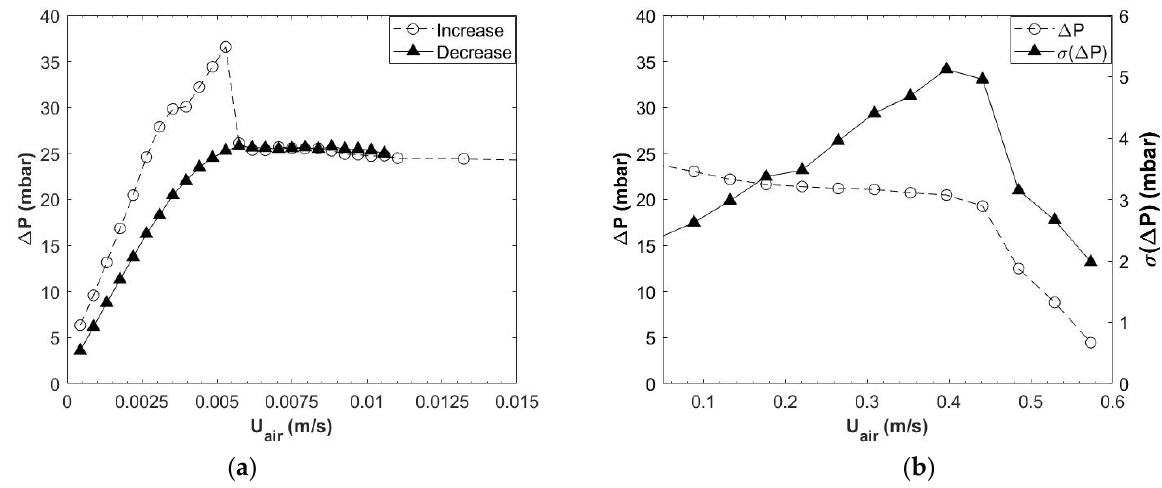
Figure 3. Determination of the characteristic fluidization velocities by common pressure drop versus the superficial air velocity ( a ) for low velocities, to identify the onset of fluidization and of bubbling, and ( b ) for high velocities, to identify the onset of the turbulent and the fast fluidization regimes. Table 1. Properties of the olivine sample